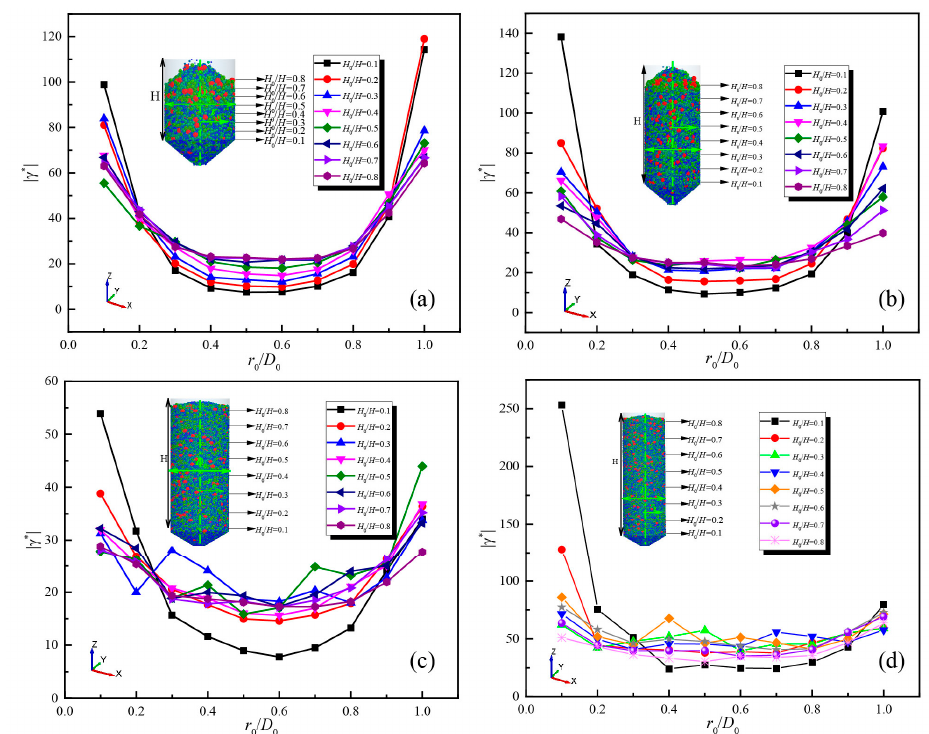
Figure 9. The variation in the shear rate tensor of the radius range for the entire sinter layers with different aspect ratios of ( a ) H / D 0 = 1, ( b ) H / D 0 = 2, ( c ) H / D 0 = 3, and ( d ) H / D 0 = 4.